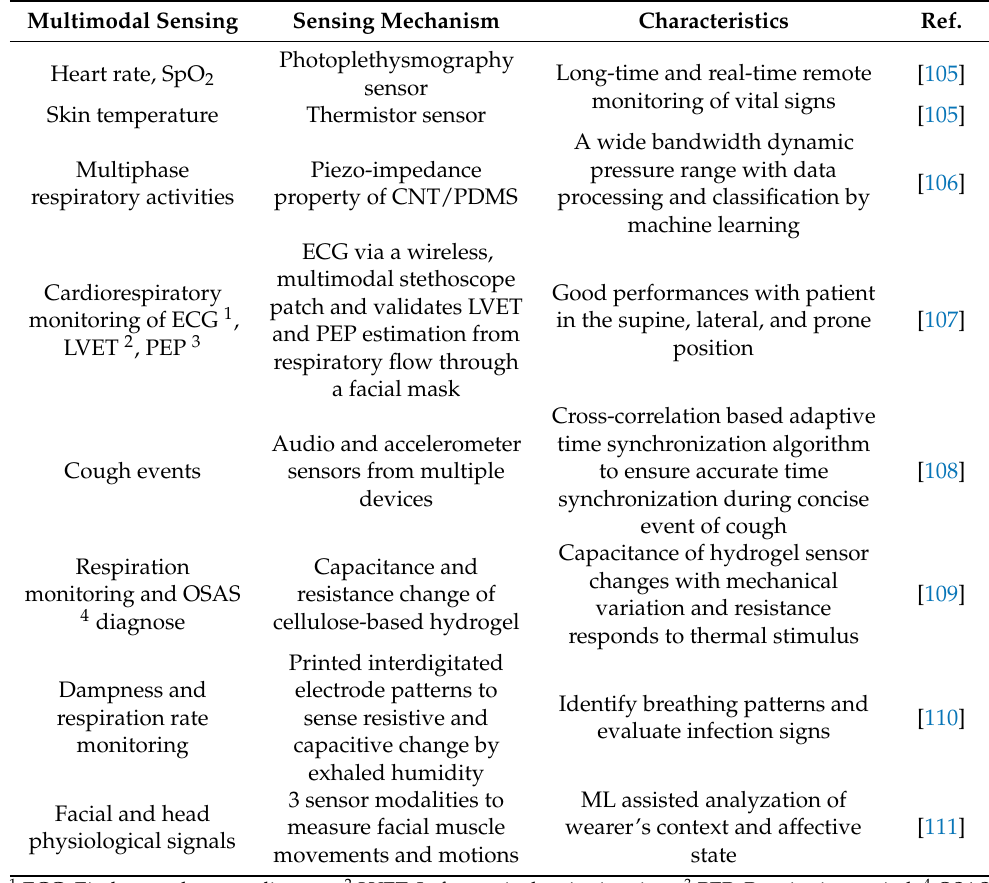
1 ECG: Einthoven electrocardiogram. 2 LVET: Left ventricular ejection time. 3 PEP: Pre-ejection period. 4 OSAS: Obstructive sleep apnea